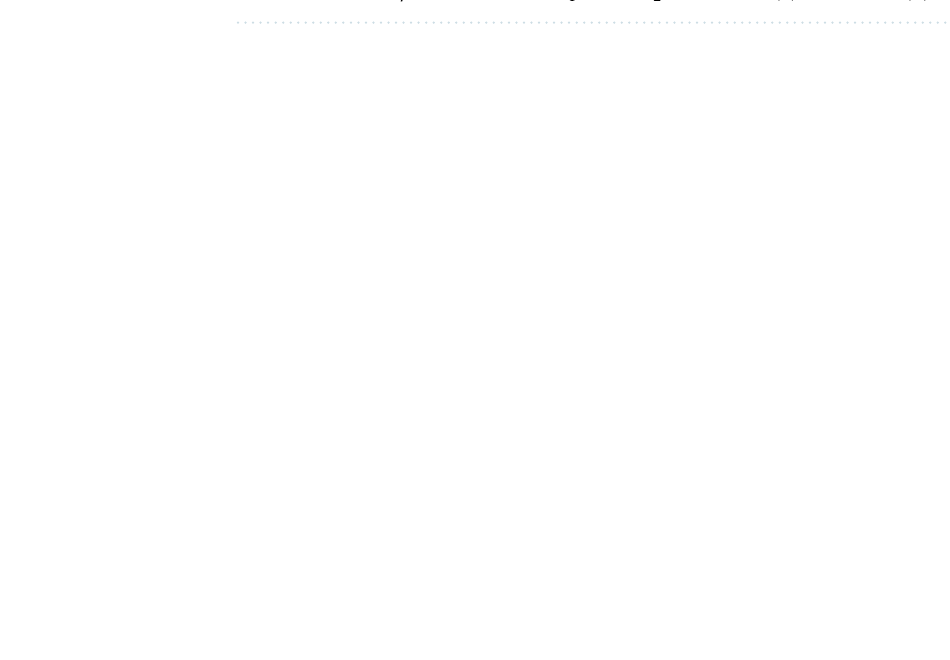
l = − 0.03 ; ( b ) l = 0.0 ; ( c ) l = 0.025 d 1 = 0.1 , 2 = 20.0 and ( a )